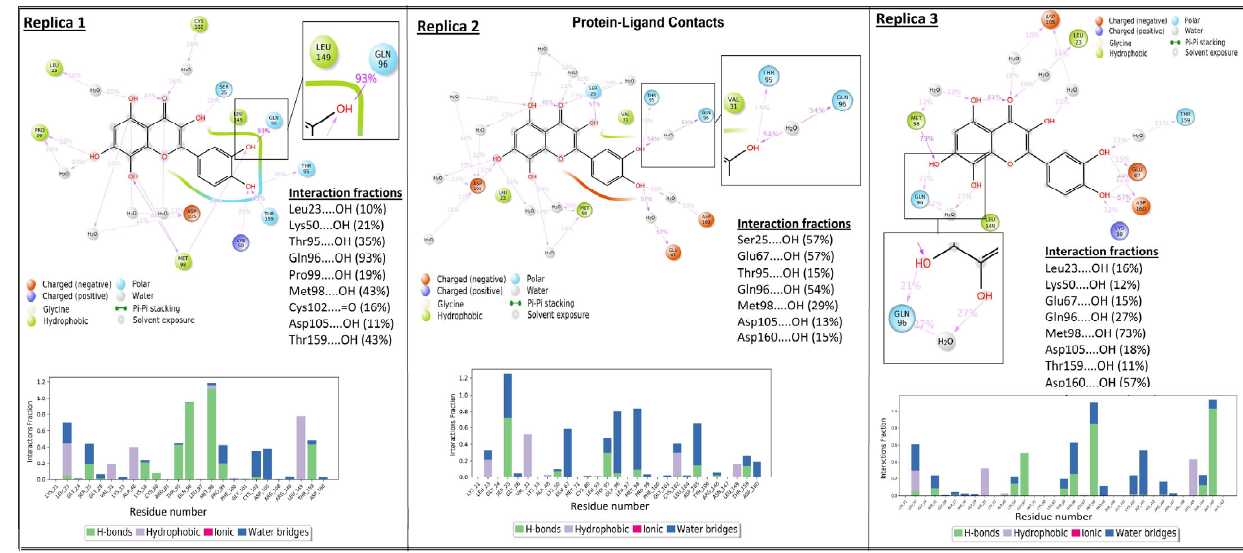
Figure 11. EGFR–Gossypetin complex sustained intermolecular interactions and percentage interac- tion fraction throughout 100 ns production